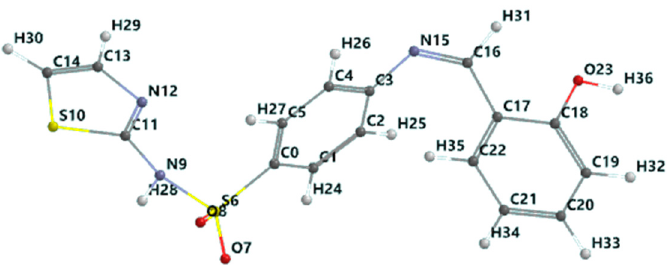
Figure 8. Schiff base optimized geometry in the singlet ground state (color codes are white: H; red: O; blue: N; black: C; and yellow: S).